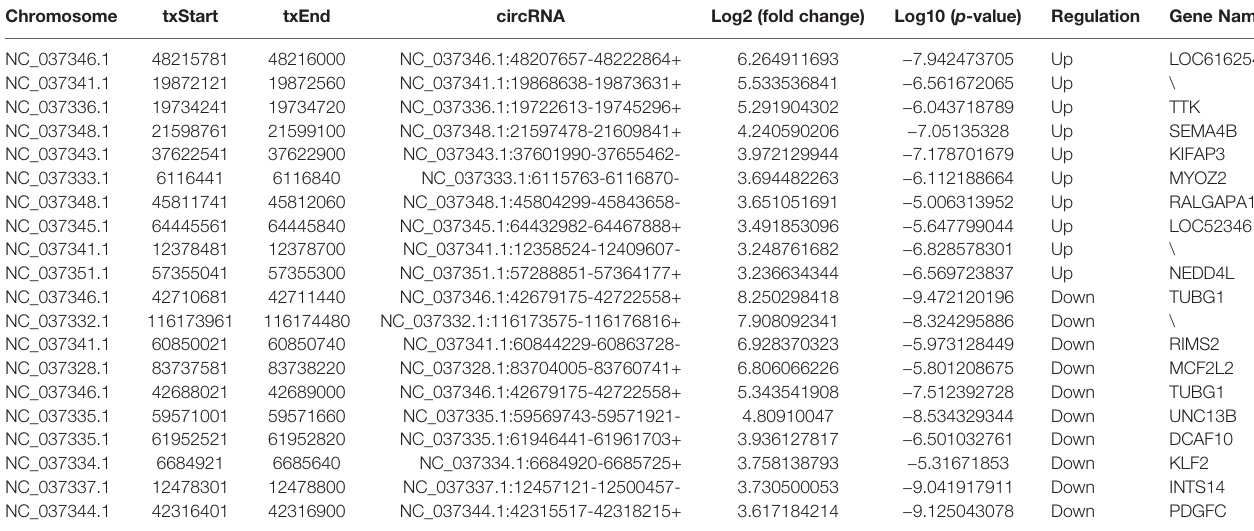
TABLE 2 | The top 20 differential m 6 A methylation peaks in the E. coli group.